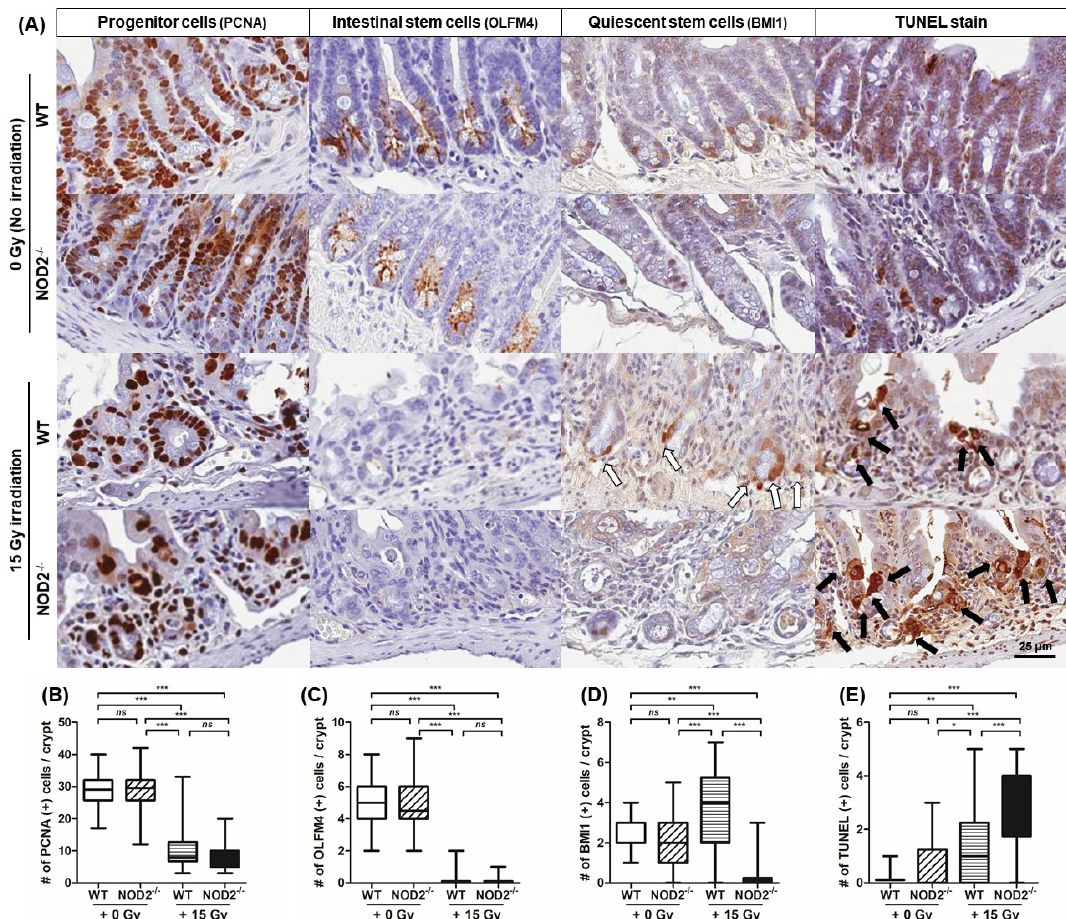
Figure 5. Immunohistochemical staining for progenitor cells, intestinal stem cells, and quiescent stem cells and TUNEL assay after 15 Gy irradiation in the WT and NOD2 − / − mice. ( A ) Immunohistochemical staining for progenitor cells, intestinal stem cells, and quiescent stem cells with OLFM4, PCNA, and BMI1. TUNEL stain for apoptic cells. White arrows indicated the BMI-positive cells. Black arrows indicated the TUNEL-positive cells. ( B ) PCNA-positive progenitor cells in the small intestinal crypt between the NOD2 − / − and WT mice and between the 0 and 15 Gy irradiations. ( C ) OLFM4-positive intestinal stem cells in the small intestinal crypt between the NOD2 − / − and WT mice and between the 0 and 15 Gy irradiations. ( D ) BMI1-positive quiescent stem cells in the small intestinal crypt between the NOD2 − / − and WT mice and between the 0 and 15 Gy irradiations. ( E ) TUNEL-positive apoptotic cells in the small intestinal crypt between the NOD2 − / − and WT mice and between the 0 and 15 Gy irradiations. Di ff erences were evaluated in 10 crypts located on three di ff erent parts of the small bowel of three WT and NOD2 − / − mice by two-way ANOVA followed by Bonferroni post-test; * p < 0.05, ** p < 0.01, and *** p < 0.001.